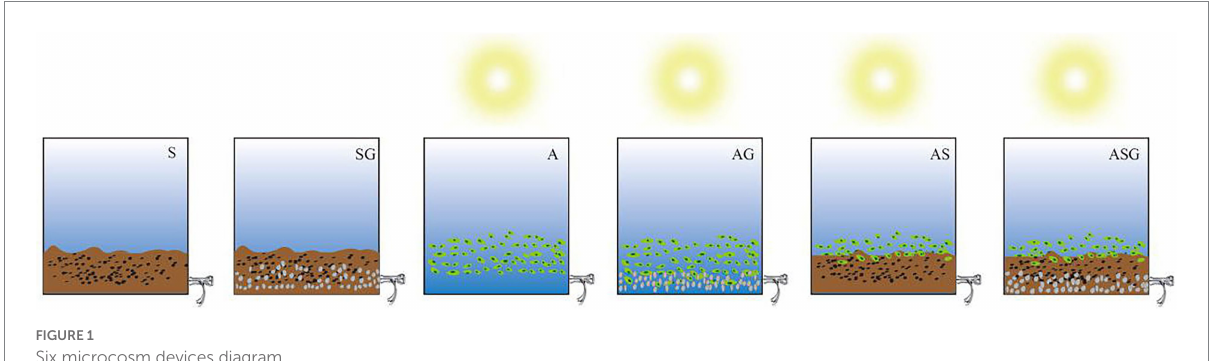
FIGURE 1 Six microcosm devices